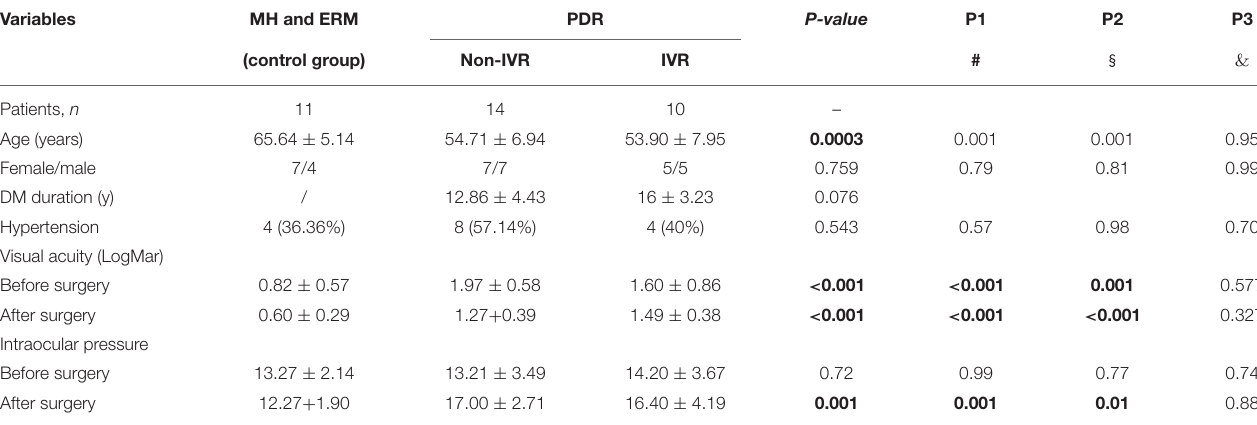
TABLE 1 | General clinical information of the